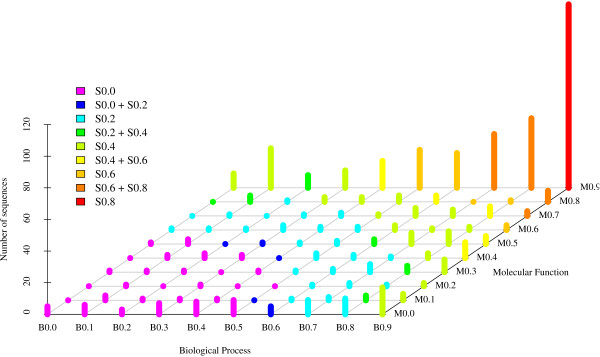
Distribution of MFscore and BPscore values for the IO dataset. The bins correspond to the same intervals as in Figure 1. The bars are colored according to the funSim score of the protein pairs contained.